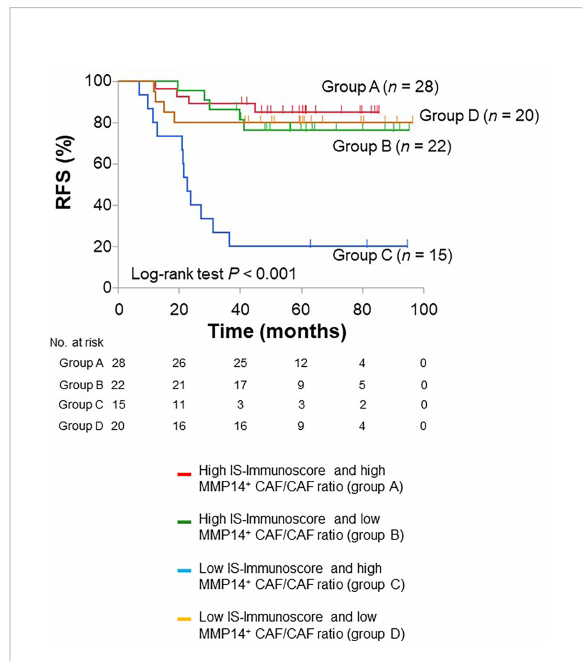
FIGURE 5 Kaplan-Meier curves for RFS based on the combination of the IS-Immunoscore and MMP14 + CAF/CAF ratio. The median value was used as the cutoff for the